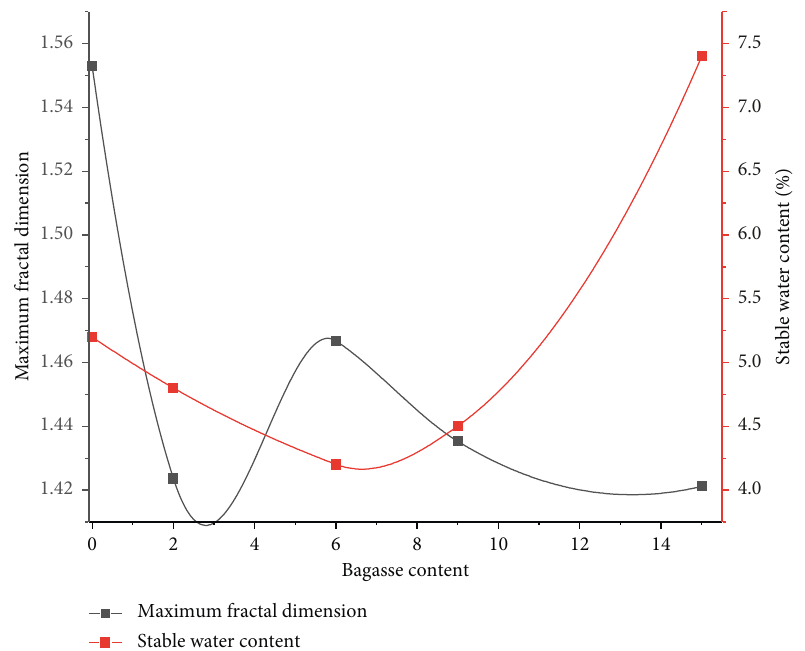
Figure 8: Relationship between water content and crack fractal dimension of clay with different bagasse